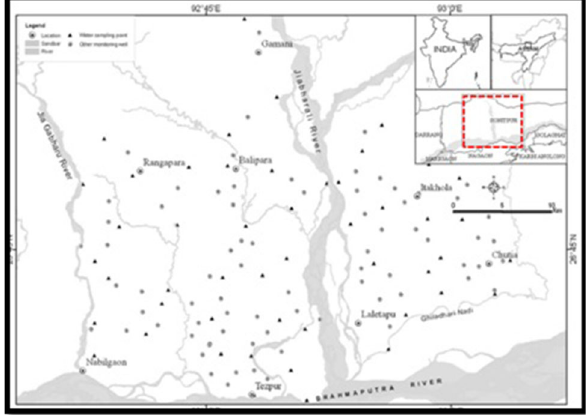
Fig. 2 Location map showing sampling locations for shallow aquifers of the study area (Khound et al.